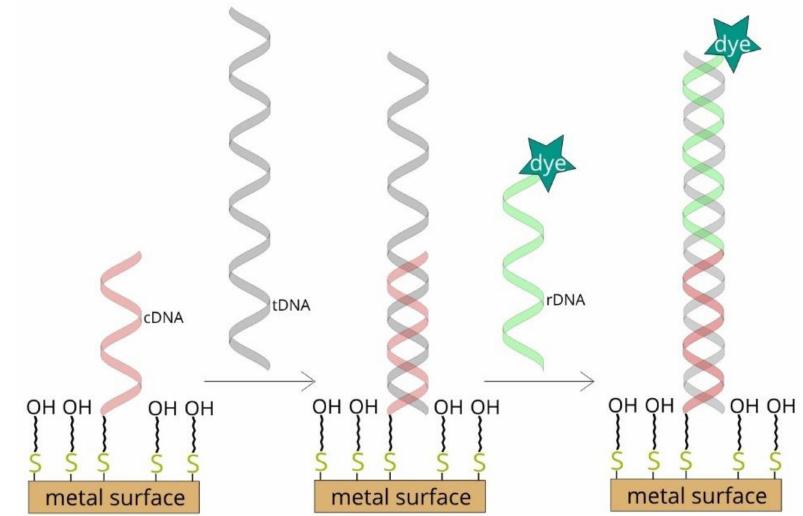
Figure 1. Diagram of surface-enhanced Raman scattering (SERS)-based DNA